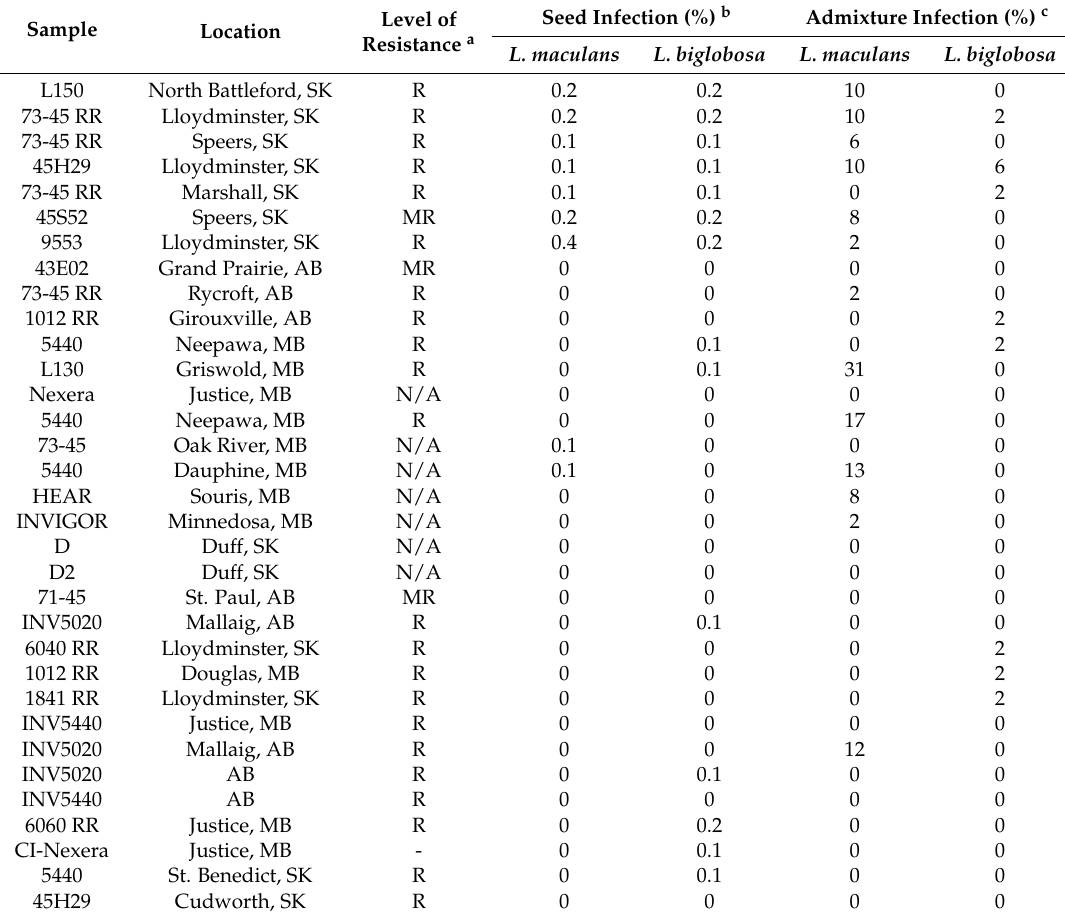
Table 2. Seed and admixture infection of commercially grown canola dockage samples across Western Canada in